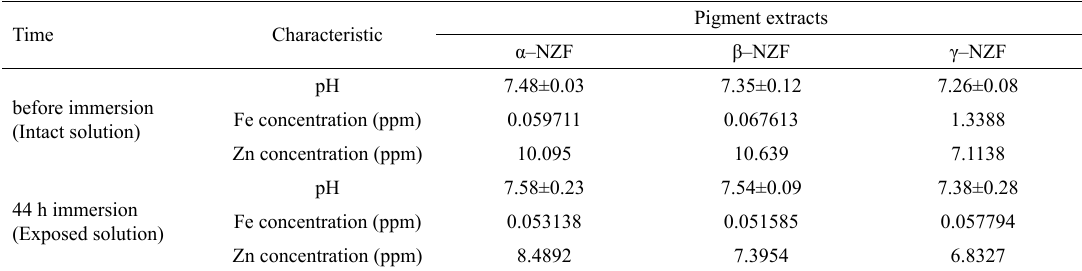
Table 4. Some characteristics of the test solutions contain α–, β–, and γ–NZF for intact solutions, before immersion of the mild steel samples and for exposed solutions, after 44 h immersion. Time